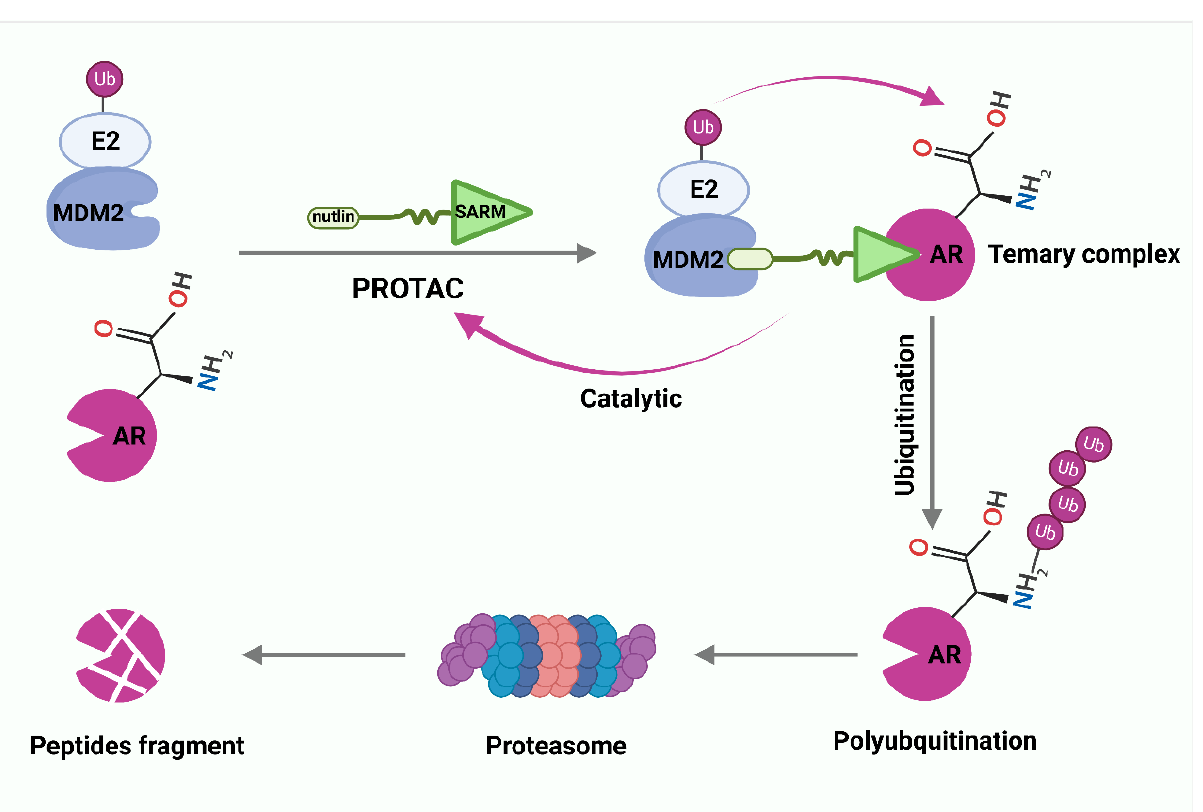
Figure 3. PROTAC-mediated degradation of target proteins through the ubiquitin – proteasome system (UPS). Selective androgen receptor modulator (SARM) and nutlin assemble into a complex that hijacks murine double minute 2 (MDM2). SARM with nutlin binds MDM2 and intracellular androgen receptor (AR), labels AR with ubiquitin, and then induces cells to remove AR by proteasomes.